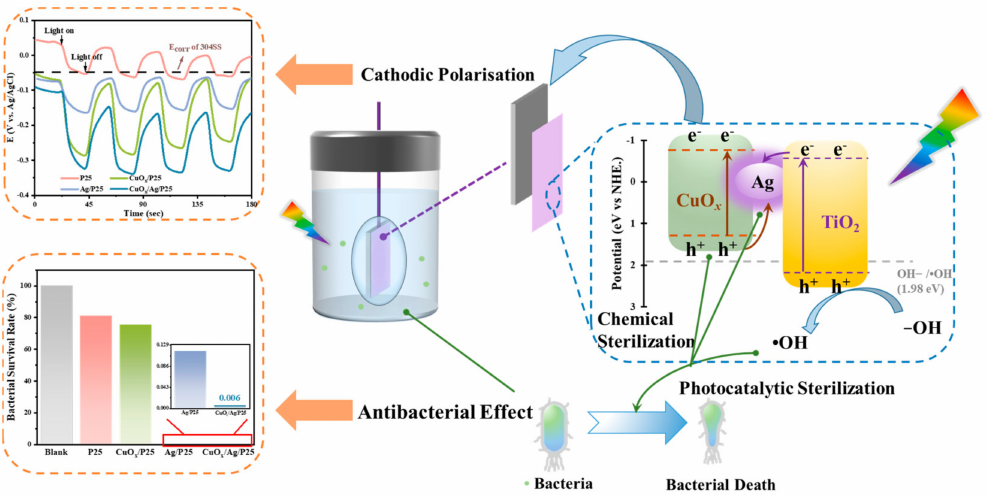
Figure 8. Schematic diagram of the antibacterial and anticorrosion dual mechanism for Cu x